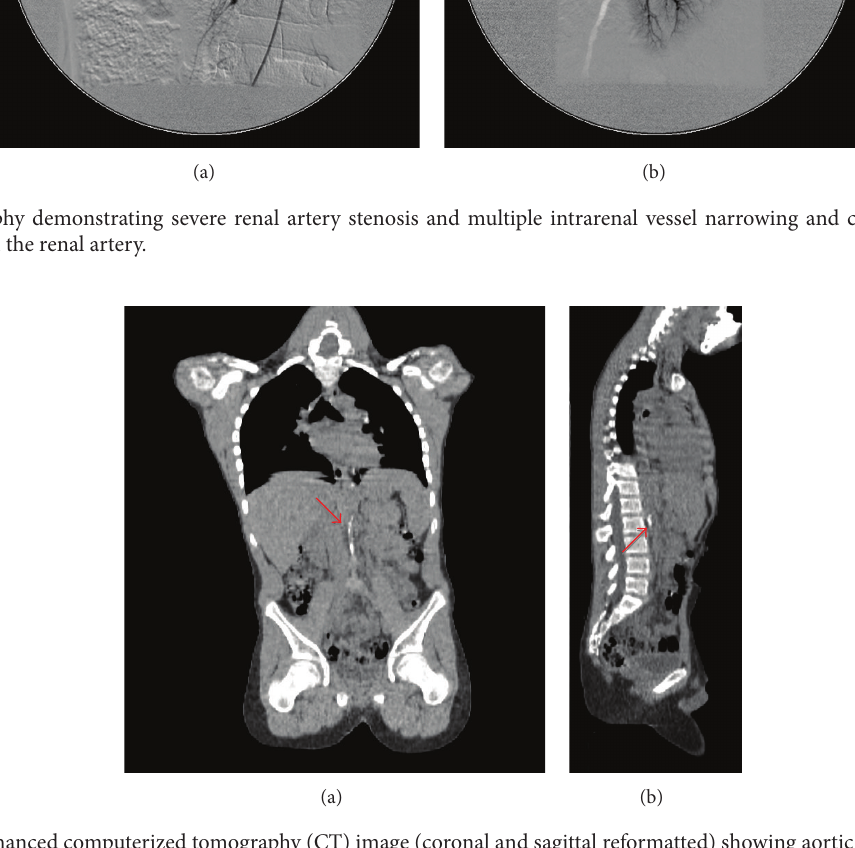
Figure 4: An unenhanced computerized tomography (CT) image (coronal and sagittal reformatted) showing aortic calcification